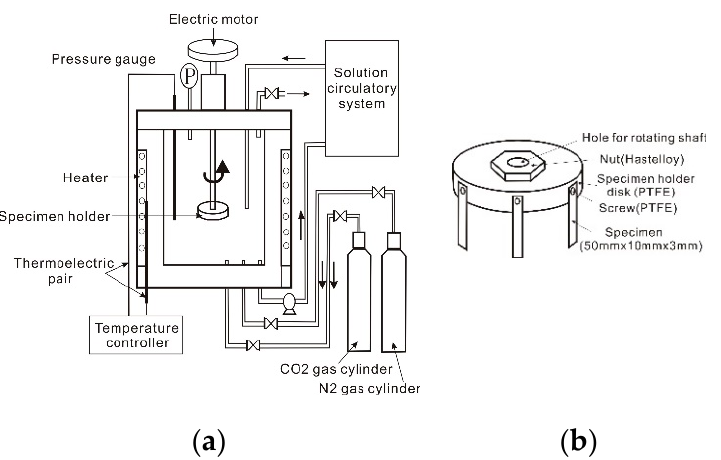
Figure 1. Microstructure of P110 steel.